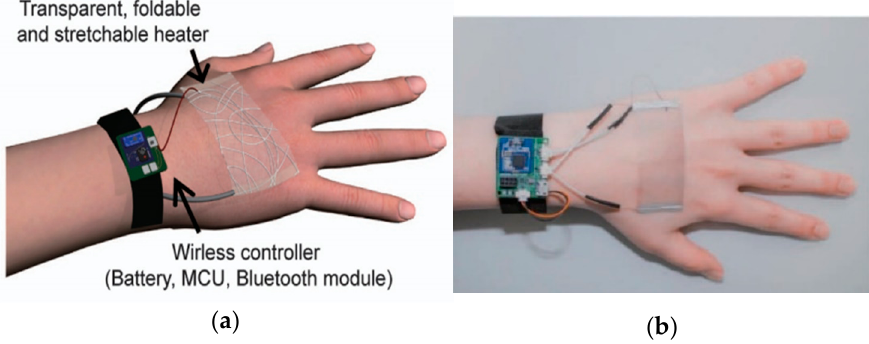
Figure 12. Transparent wireless heat patch with a microcontroller (MCU): ( a ) wireless controller and stretchable heater, and ( b ) a stretchable heater worn on the arm. Figure reproduced with permission from Jang et al. [100] .